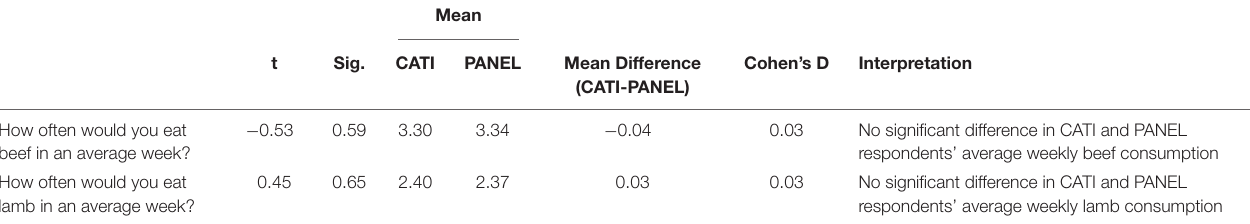
TABLE 6 | Independent 2-tailed t -tests (df = 1029) comparing the consumer behavior of the CATI survey and the PANEL survey respondents with education as a